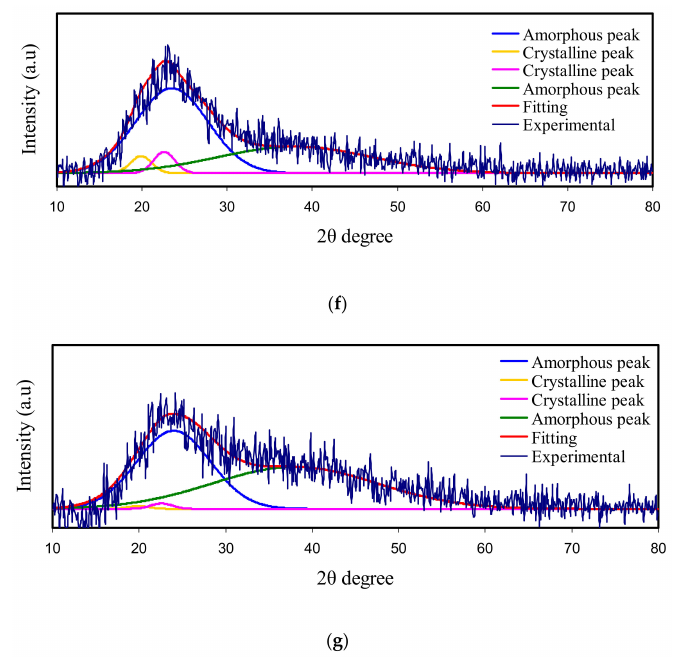
Figure 1. XRD spectra for ( a ) pure PVA, ( b ) pure CS, ( c ) PVA:CS-blend ( d ) PVSCGP0, ( e ) PVSCGP1, ( f ) PVSCGP2, and ( g ) PVSCGP3 electrolyte films.